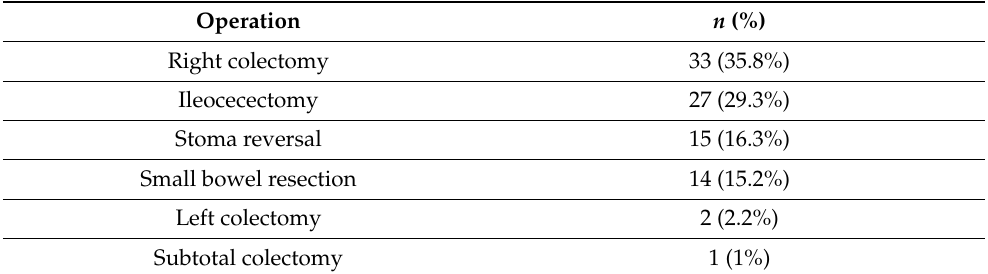
Table 2. Types of operations.